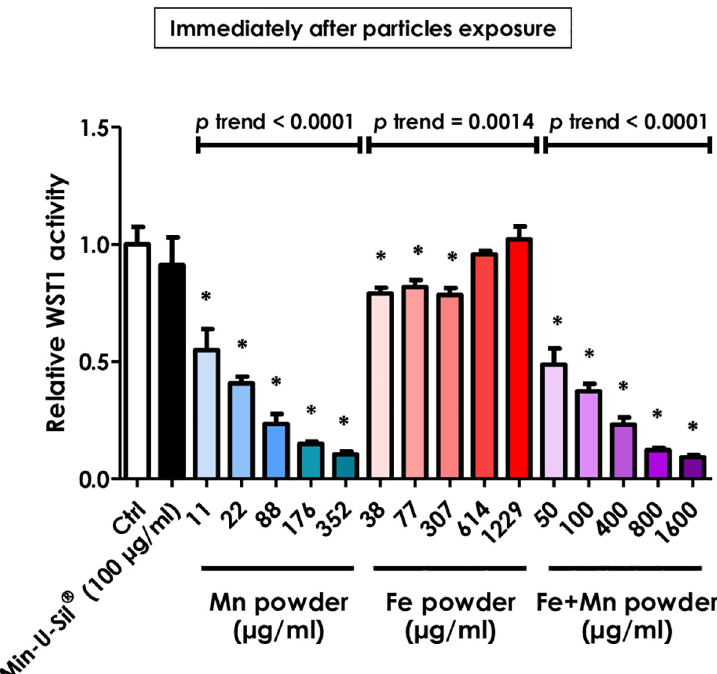
Fig 5. The WST-1 assay indicates a false cytotoxicity after direct addition of Mn powder to HUVECs. HUVECs were seeded in 96-well plates and exposed the next day to different concentrations of Mn, Fe, or Fe+Mn powder. The cells were not washed and immediately incubated in fresh medium with 10% WST-1 reagent for 2h. Absorbance was measured at 450 nm, with 690 nm as reference. Results are reported as relative WST-1 activity, where 1.0 corresponds to the value measured in control cultures. Min-U-Sil 1 was used as positive control. Fe+Mn: mixture of 77 wt.% of Fe powder with 22 wt.% of Mn powder. Values are means ± SEM (n = 8), � p < 0.05 relative to control (One-way ANOVA followed by a Dunnett’s multiple comparison). The trend test included